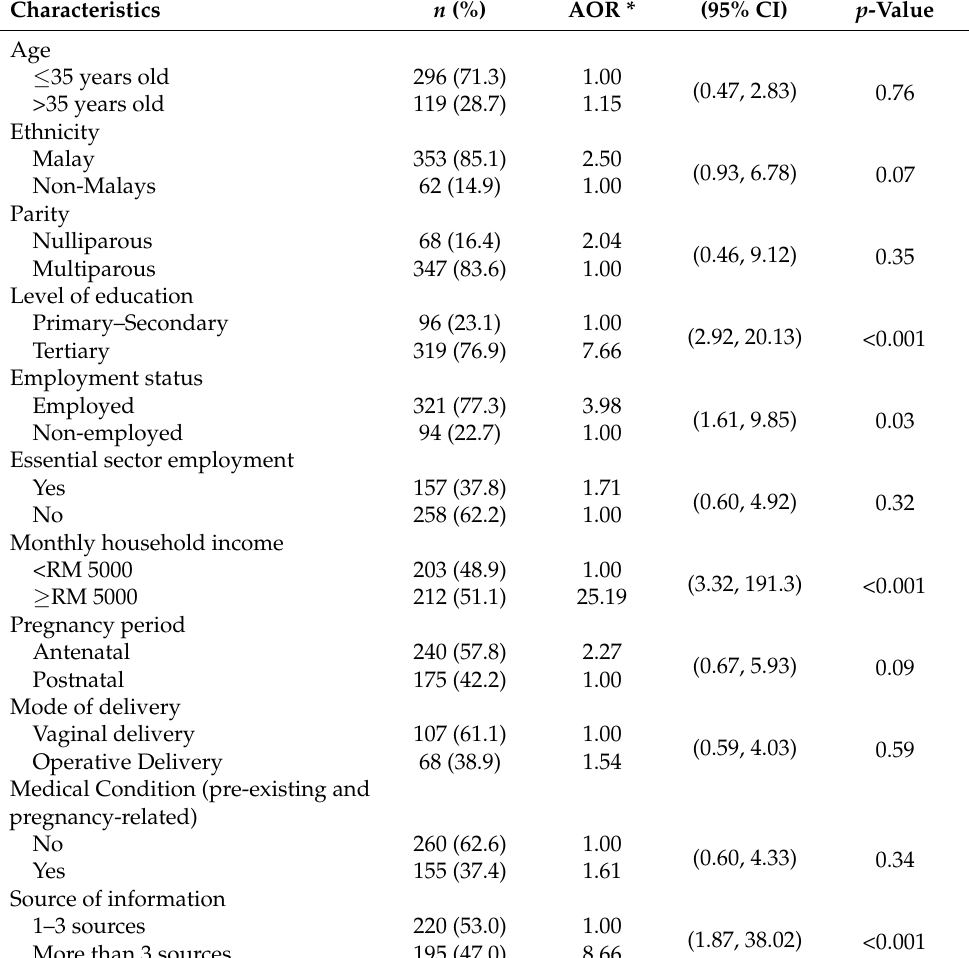
Table 1. Demographic characteristics and respective adjusted odd ratios for adequate knowledge on